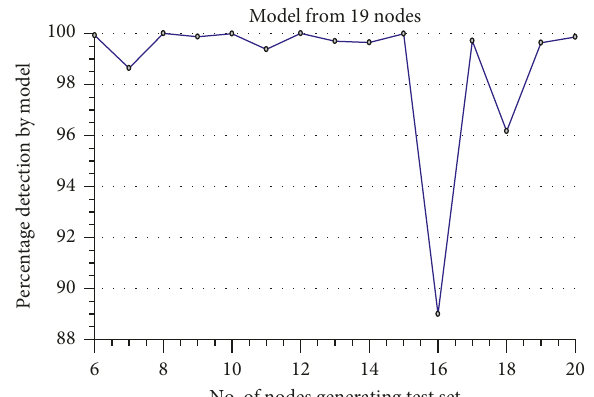
Figure 21: Simulation results for 19 nodes.